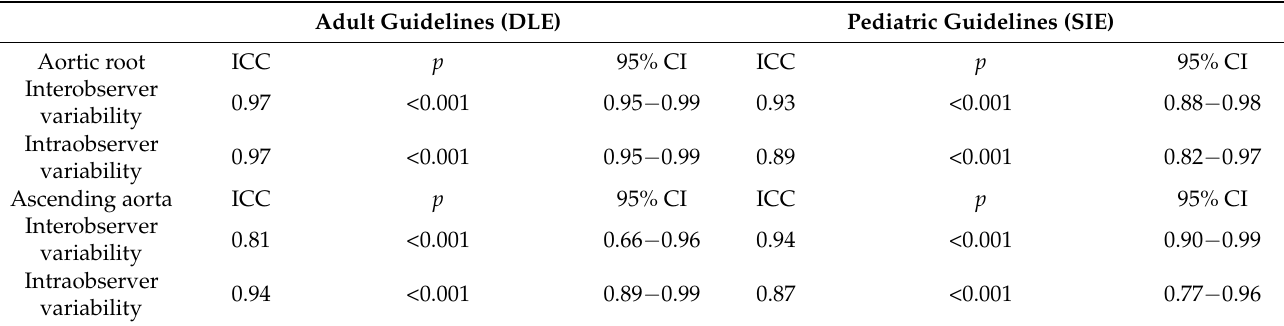
Table 3. Intraobserver and interobserver variability in 20 random patients. Adult Guidelines